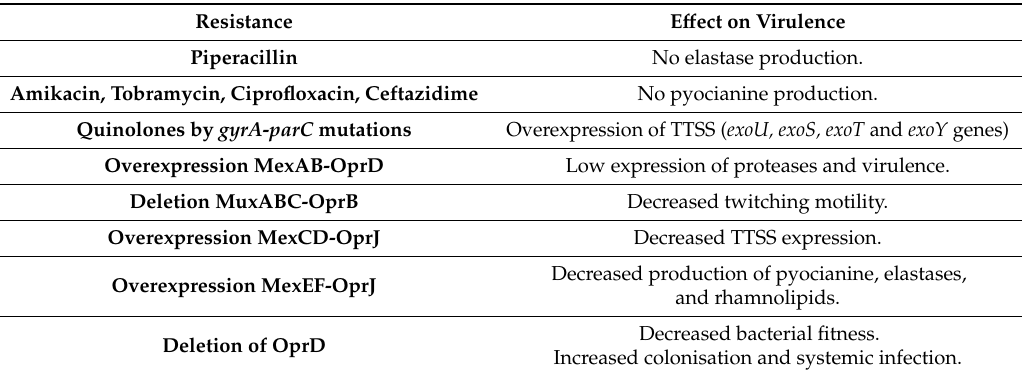
Table 2. Relationship resistance-virulence among P. aeruginosa explained in this review.